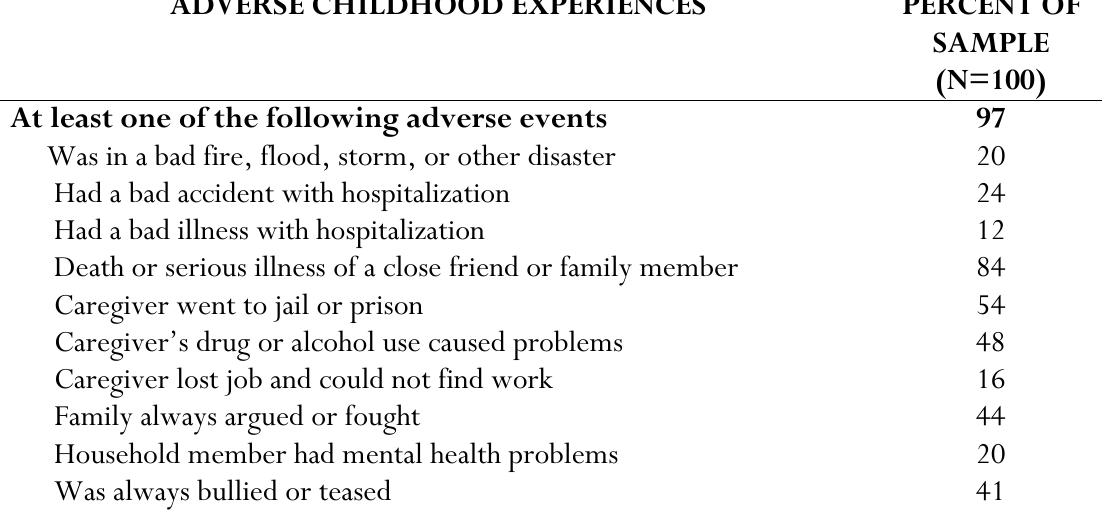
Table 3: Prevalence of Self-Reported Non-Victimization